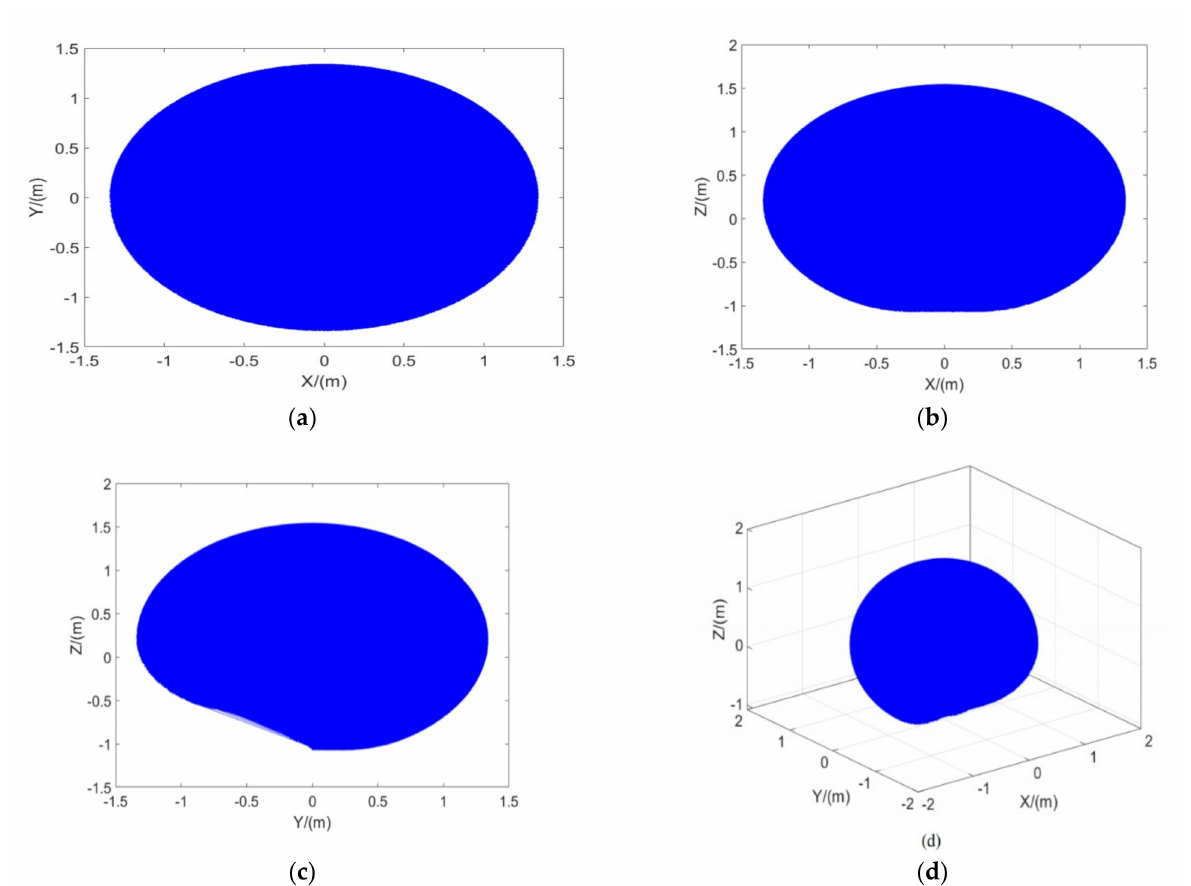
Figure 4. The reachable workspace simulation diagram: ( a ) The XOY coordinate plane projection drawing of workspace; ( b ) The XOZ coordinate plane projection drawing of workspace; ( c ) The YOZ coordinate plane projection drawing of workspace; ( d ) Isometric view of workspace.